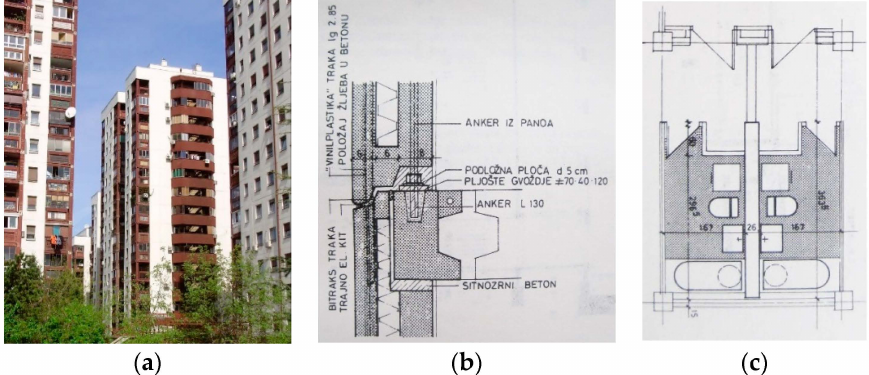
Figure 11. ( a ) Building A-12 and B-12 in block 63 ( b ) Façade panel and floor slab connections ( c ) Industrialized sanitary block (source: original drawing sheet from Historical Archives of New Belgrade,